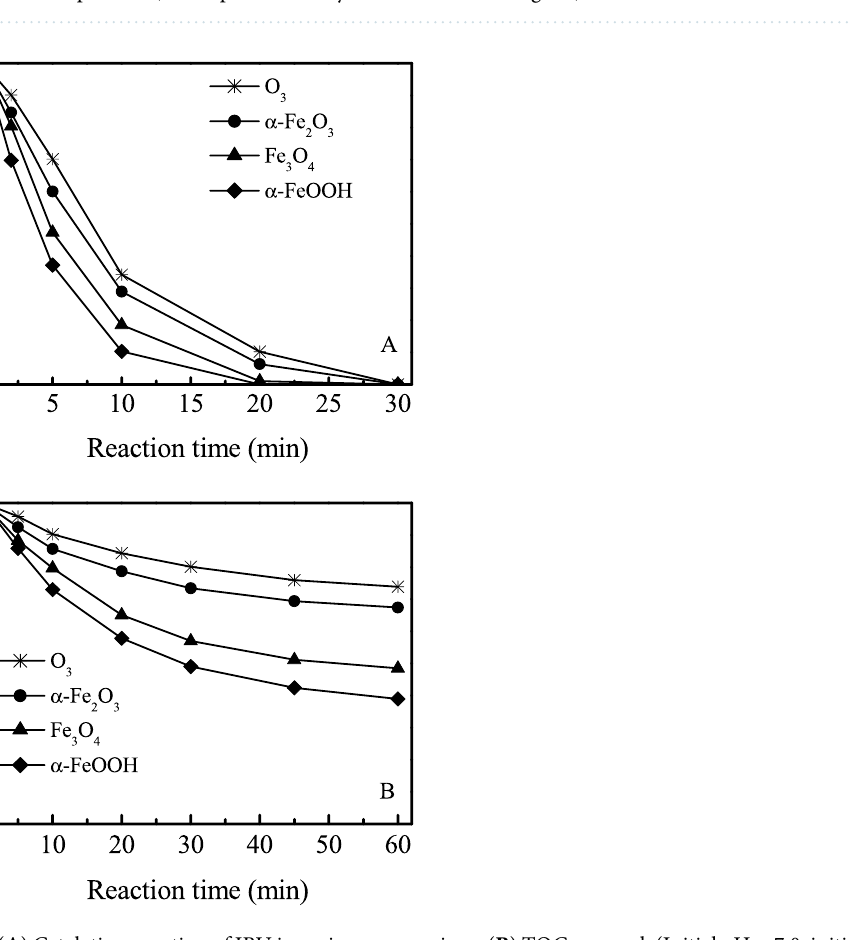
Figure 8. The concentration of surface Fe 2 + on α -Fe 2 O 3 , Fe 3 O 4 and α -FeOOH aqueous dispersions during catalytic ozonation process. (Initial pH: 7.0, catalyst concentration: 1.5 g L − 1 ).